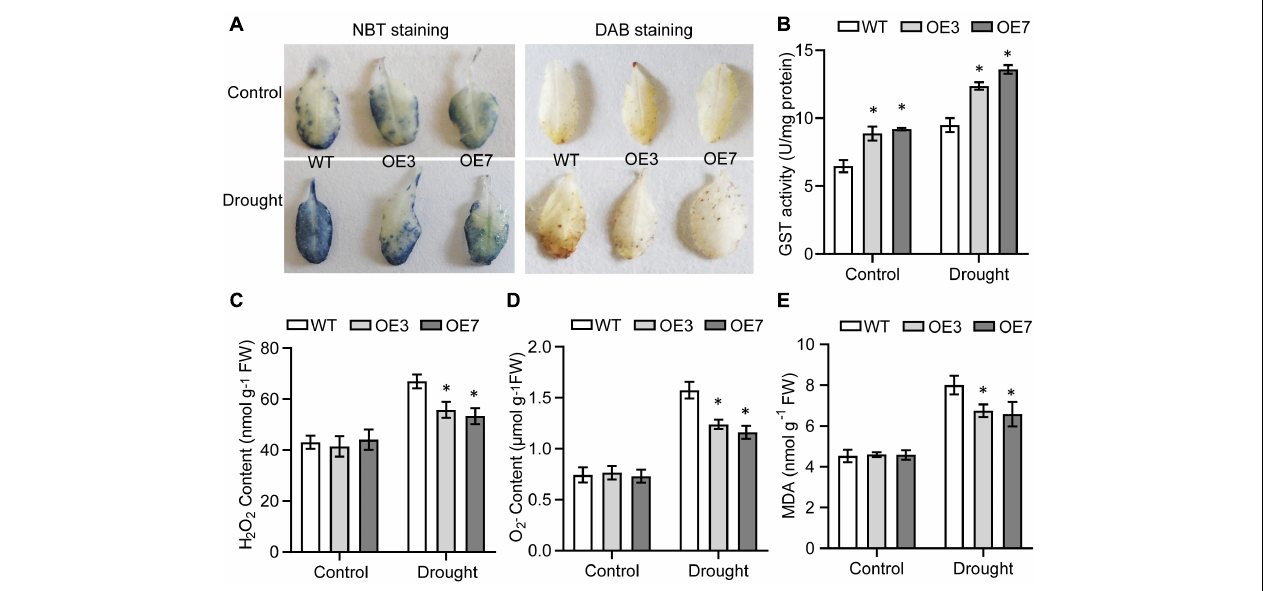
FIGURE 4 | Overexpression of CsGSTU8 alleviated ROS and MDA accumulation under drought stress. (A) Histochemical detection of O 2 − and H 2 O 2 via NBT staining and DAB staining, respectively. (B) Measurement of GST activity under control and drought conditions. (C) Measurement of H 2 O 2 content under control and drought conditions. (D) Measurement of O 2 − content under control and drought conditions. (E) Measurement of MDA content under control and drought conditions. The Data are presented as the means ± SDs of three independent experiments. Significant differences were determined using Student’s t -test ( ∗ P < 0.05).